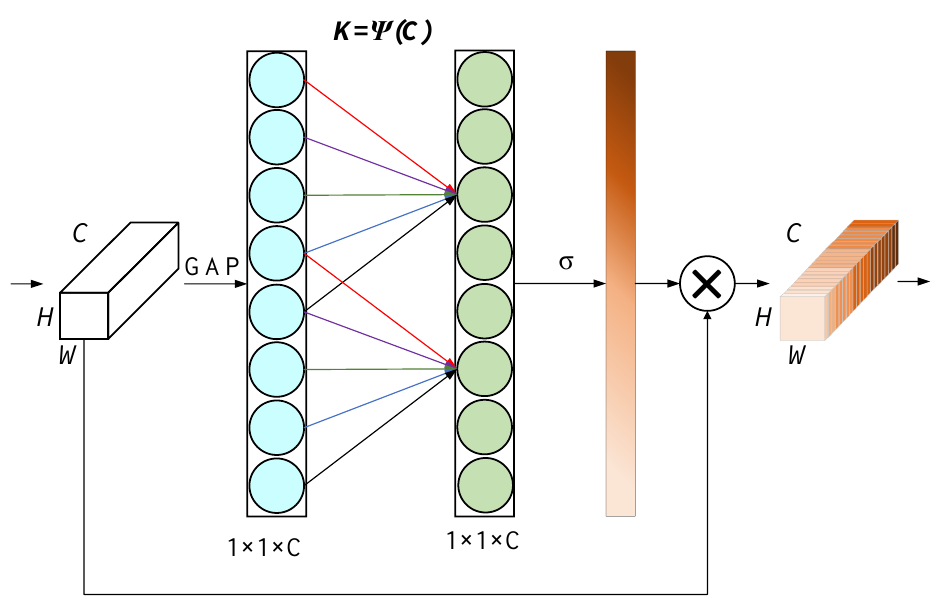
Figure 6. ECA structure diagram.